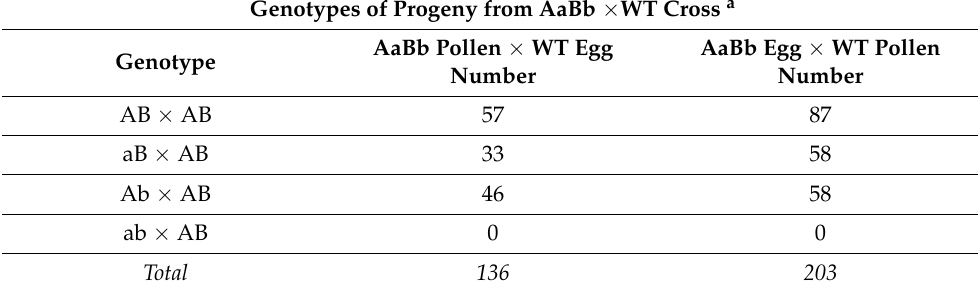
Table 2. pbe1 pbe2 Double Mutants Are Gametophytic Lethal. Genotypes of Progeny from AaBb ×WT Cross a